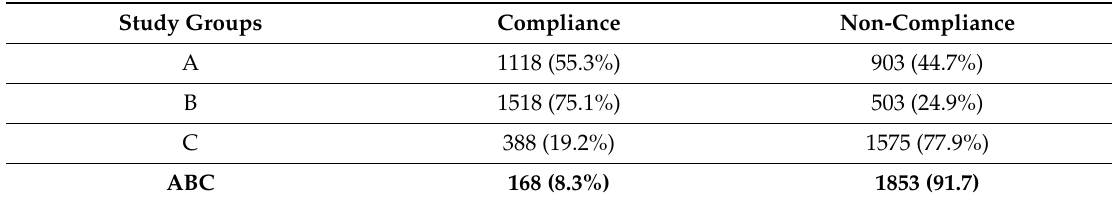
Table 2. ABC pathway compliance.